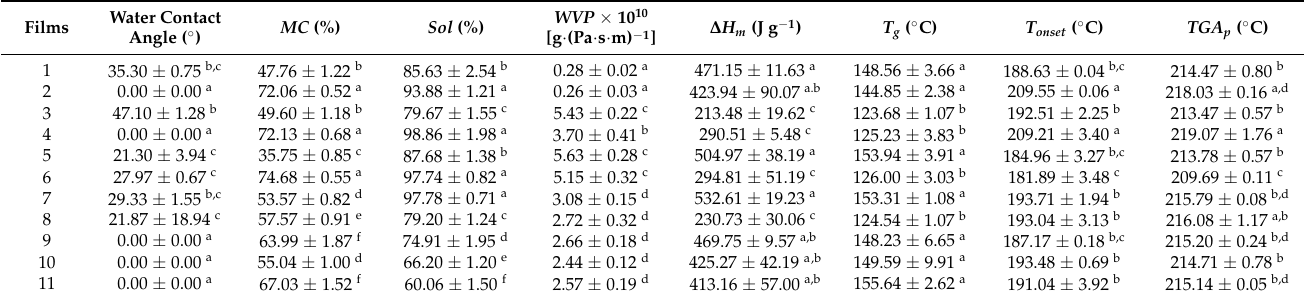
Table 3. Water contact angle (180 s after the water drop deposition), moisture content ( MC ), solubility ( Sol ), water vapor permeability ( WVP ), enthalpy of melting ( ∆ H m ), glass transition temperature ( T g ), onset temperature ( T onset ), and TGA peak ( TGA p ) for alginate films with amaranth phenolic